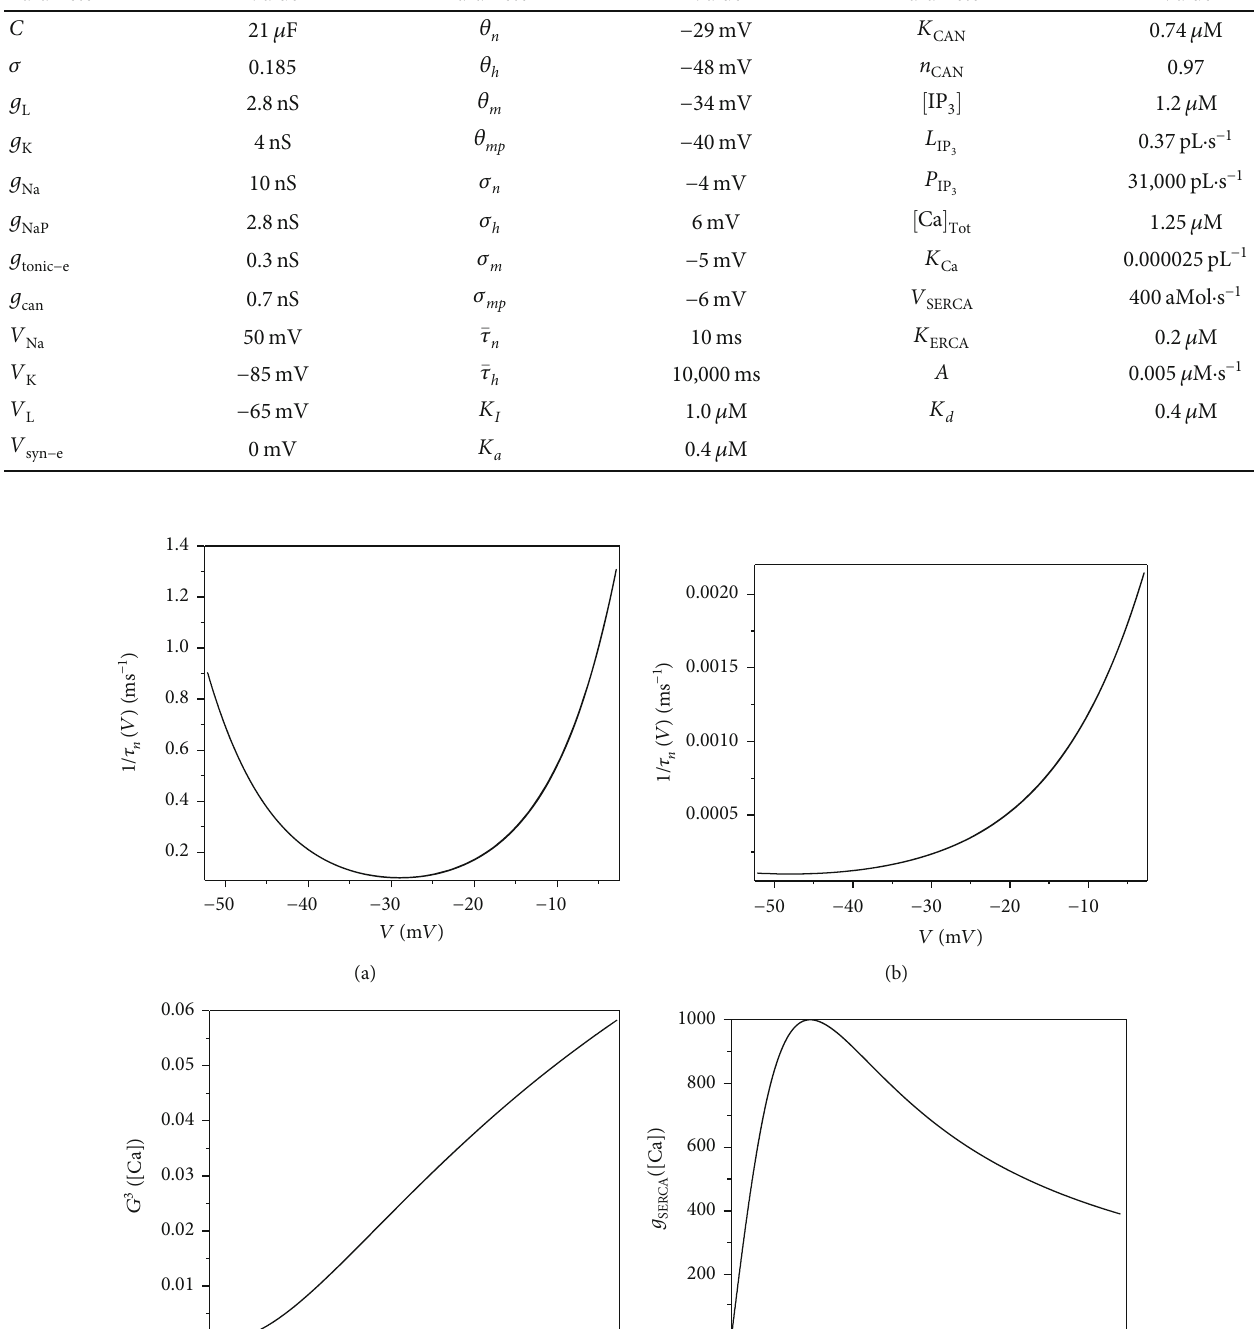
ð V Þ with membrane potential V , (b) 1/ τ n